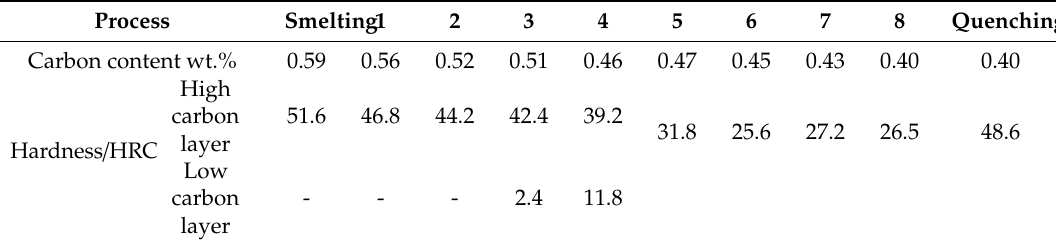
Table 2. The carbon content and hardness variety in each process of Group 3.